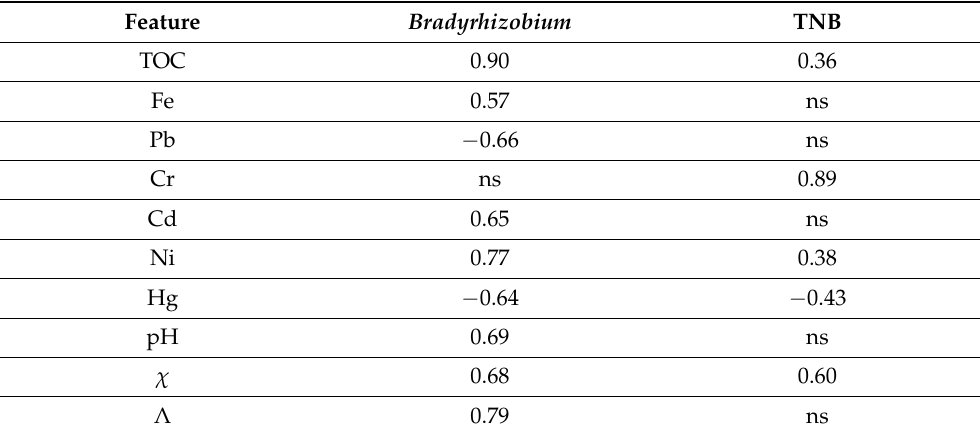
Table 3. Correlation between the growth of TNB, (cfu/g) Bradyrhizobium (cfu/nodule) and Fe (%) and other heavy metals’ (mg · kg − 1 ) concentrations.